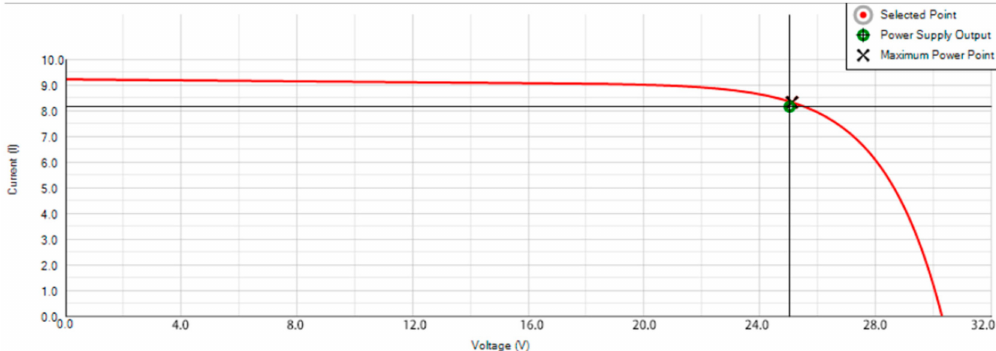
Figure 22. PR port voltage and current under PV Mode (Figure from MAGNA-POWER